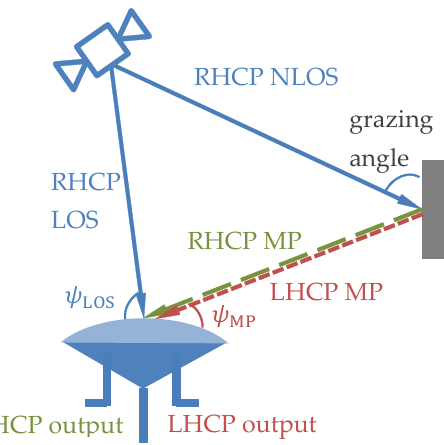
Figure 1. The components of the received signal by a dual-polarization antenna.